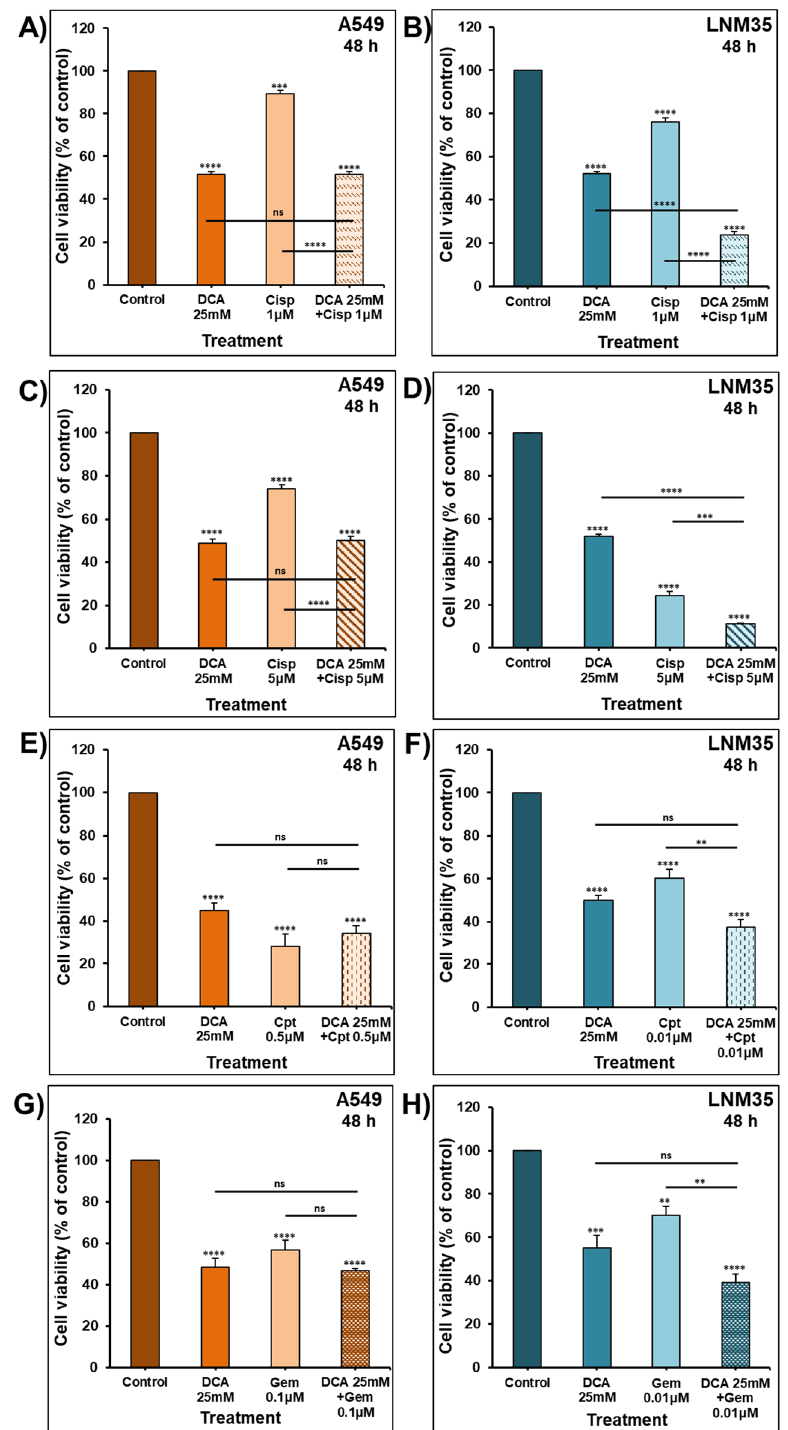
Figure 8. Effect of DCA in combination with chemotherapeutic agents on the viability of NSCLC cells. Exponentially growing A549 cells ( A , C ) and LNM35 cells ( B , D ) were treated, in 96-well plate for 48 h, with DCA (25 mM) ± cisplatin (1, 5 µM). Similarly, exponentially growing A549 cells were treated, in 96-well plate for 48 h, with DCA (25 mM) in combination with camptothecin (0.5 µM) ( E ) or gemcitabine (0.1 µM) ( G ) while LNM35 cells were treated with camptothecin (0.01 µM) ( F ) or gemcitabine (0.01 µM) ( H ). Cellular viability was determined using CellTiter Glo luminescent assay as described in the Material and Methods. Experiments were repeated at least 3 times. Columns represent means; bars represent S.E.M. ** Significantly different at <0.01. *** Significantly different at <0.001. **** Significantly different at <0.0001. ns—non-significant.